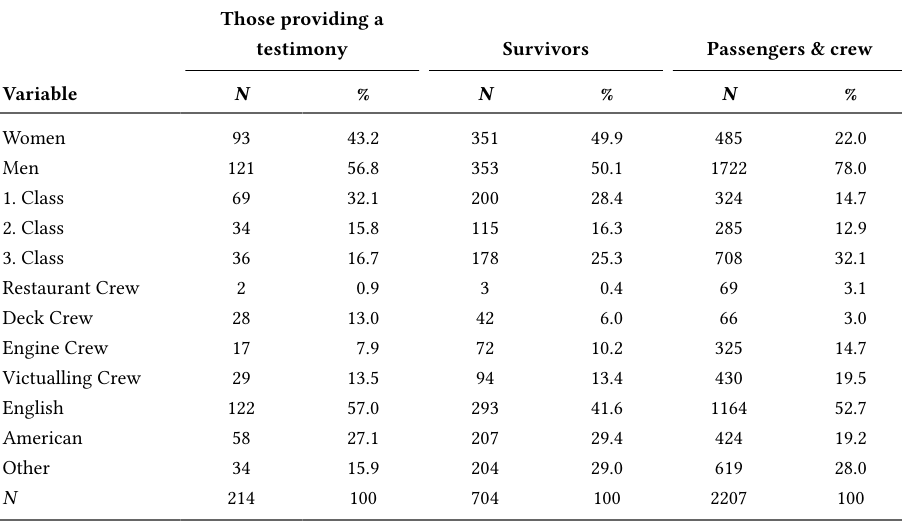
Passengers & Crew, Survivors, and Those Providing a Testimony Those providing a Variable